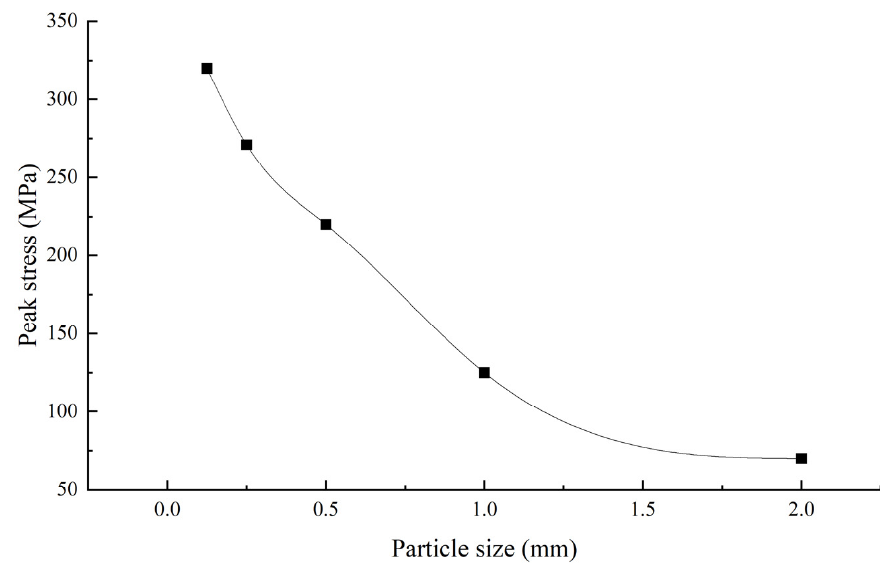
Figure 9. When the particle size is large, the peak stress is small and sensitive .